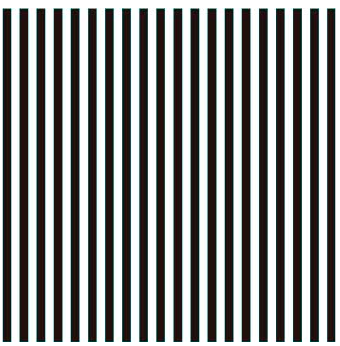
Figure 14. A centrally symmetric periodic grating target.